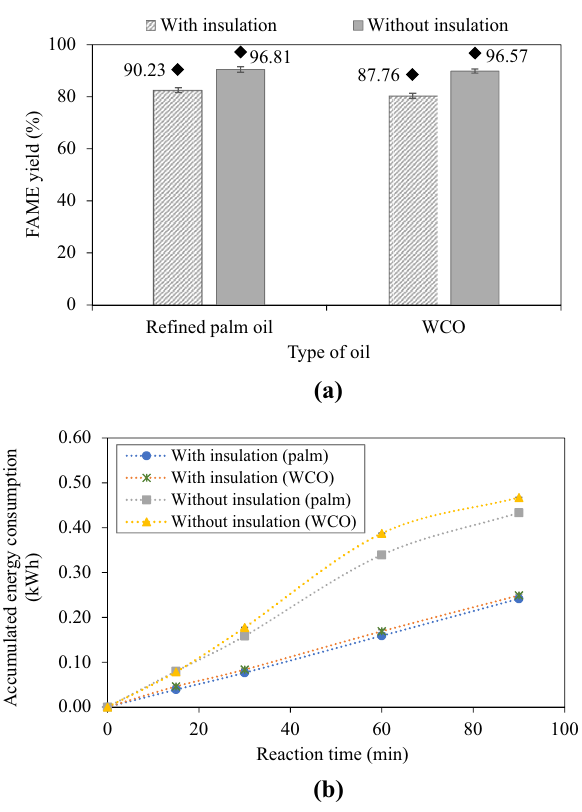
Figure 9. ( a ) Effect of insulation on steady-state FAME yield and ( b ) accumulated energy consumption (2000 mL, 50 mL/min, 1 wt% NaOH, 62–63 °C), ♦ = after